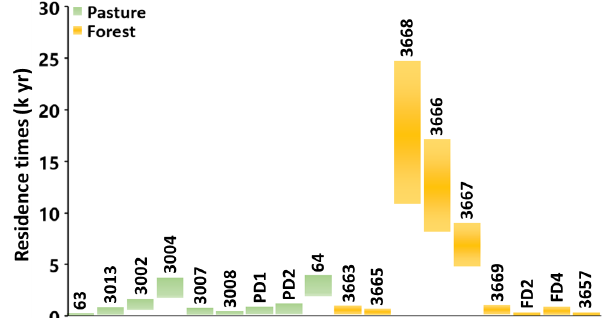
Figure 6. Ranges of groundwater residence times (in kyr) estimated using different LPMs. The numbers above the boxes represent sam- ple IDs. PD and FD represent the shallow groundwater in the pas- ture drainage and forest drainage areas, respectively. Data are from